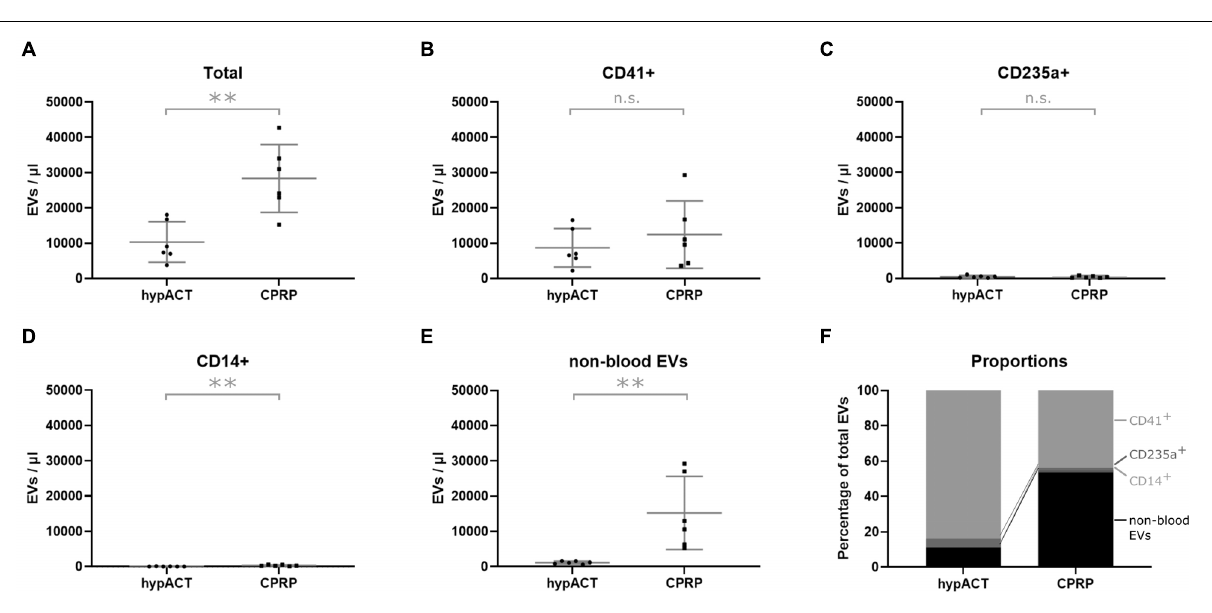
FIGURE 2 | Tissue origin of EVs in blood products determined via flow cytometry. (A) Total extracellular vesicle (EV) concentration, (B) platelet-derived EVs (CD41 + ), (C) erythrocyte-derived EVs (CD235a + ), (D) monocyte-derived EVs (CD14 + ), (E) non-blood EVs, (F) fractional composition of EV population by tissue origin. Data from n=6 donors are shown with SD error bars. ** p <